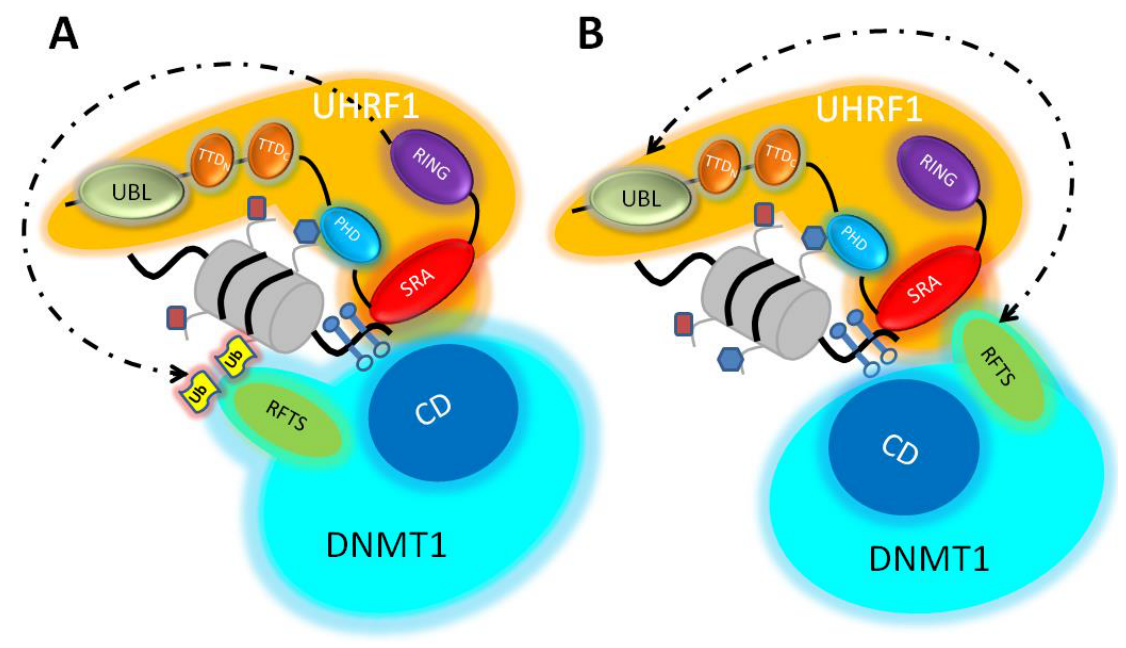
Figure 2. Dialogue model between UHRF1 and DNA methyltransferase 1 (DNMT1) in the presence of hemi-methylated DNA. ( a ) Model A: targeting of DNMT1 to chromatin via histone H3-dependent ubiquitination. Two molecules of ubiquitin (Ub) on the nucleosome, mediated by the RING domain of UHRF1 (dotted line), serve as an anchorage for DNMT1 via the replication focus targeting sequence (RFTS) domain. This interaction allows the alleviation of the auto-inhibitory activity of RFTS on the catalytic domain (CD) of DNMT1. Concomitantly, the TTD binds di/trimethylated lysine 9 on histone H3 (ocher rectangle on nucleosome) and the PDH binds unmodified arginine 2 on histone H3 (blue hexagon on nucleosome). ( b ) Model B: targeting of DNMT1 to chromatin via UHRF1 domain interactions. The UBL (dotted line) and SRA domain interact with the RFTS domain of UHRF1, allowing the release of the catalytic domain (CD) of DNMT1. As with model A, the TTD binds di/trimethylated lysine 9 on histone H3 (ocher rectangle on nucleosome) and the PDH binds unmodified arginine 2 on histone H3 (blue hexagon on nucleosome).